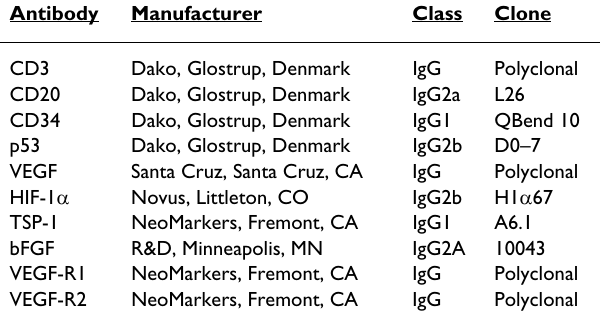
Table 1: Antibodies used for immunohistochemistry